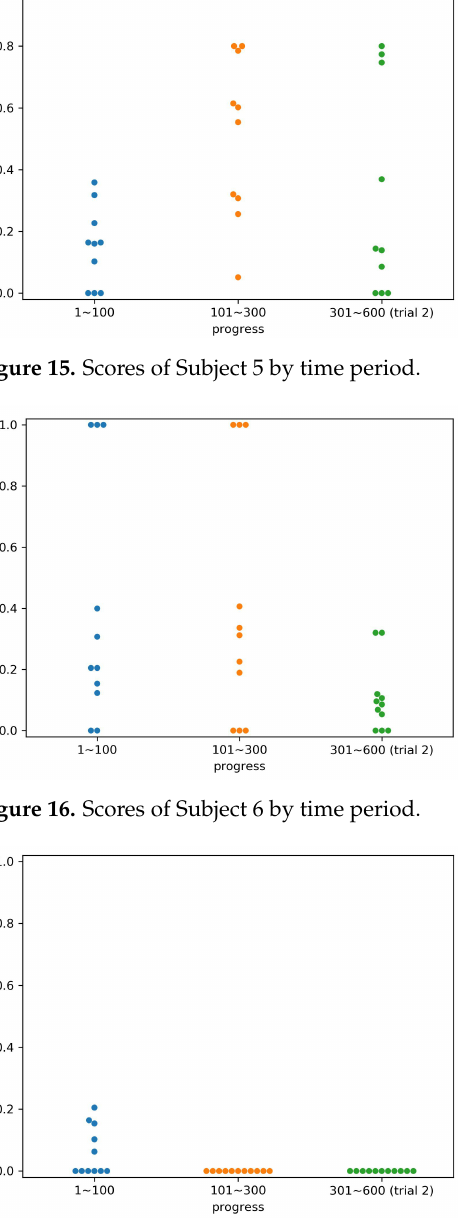
Figure 17. Scores of Subject 7 by time